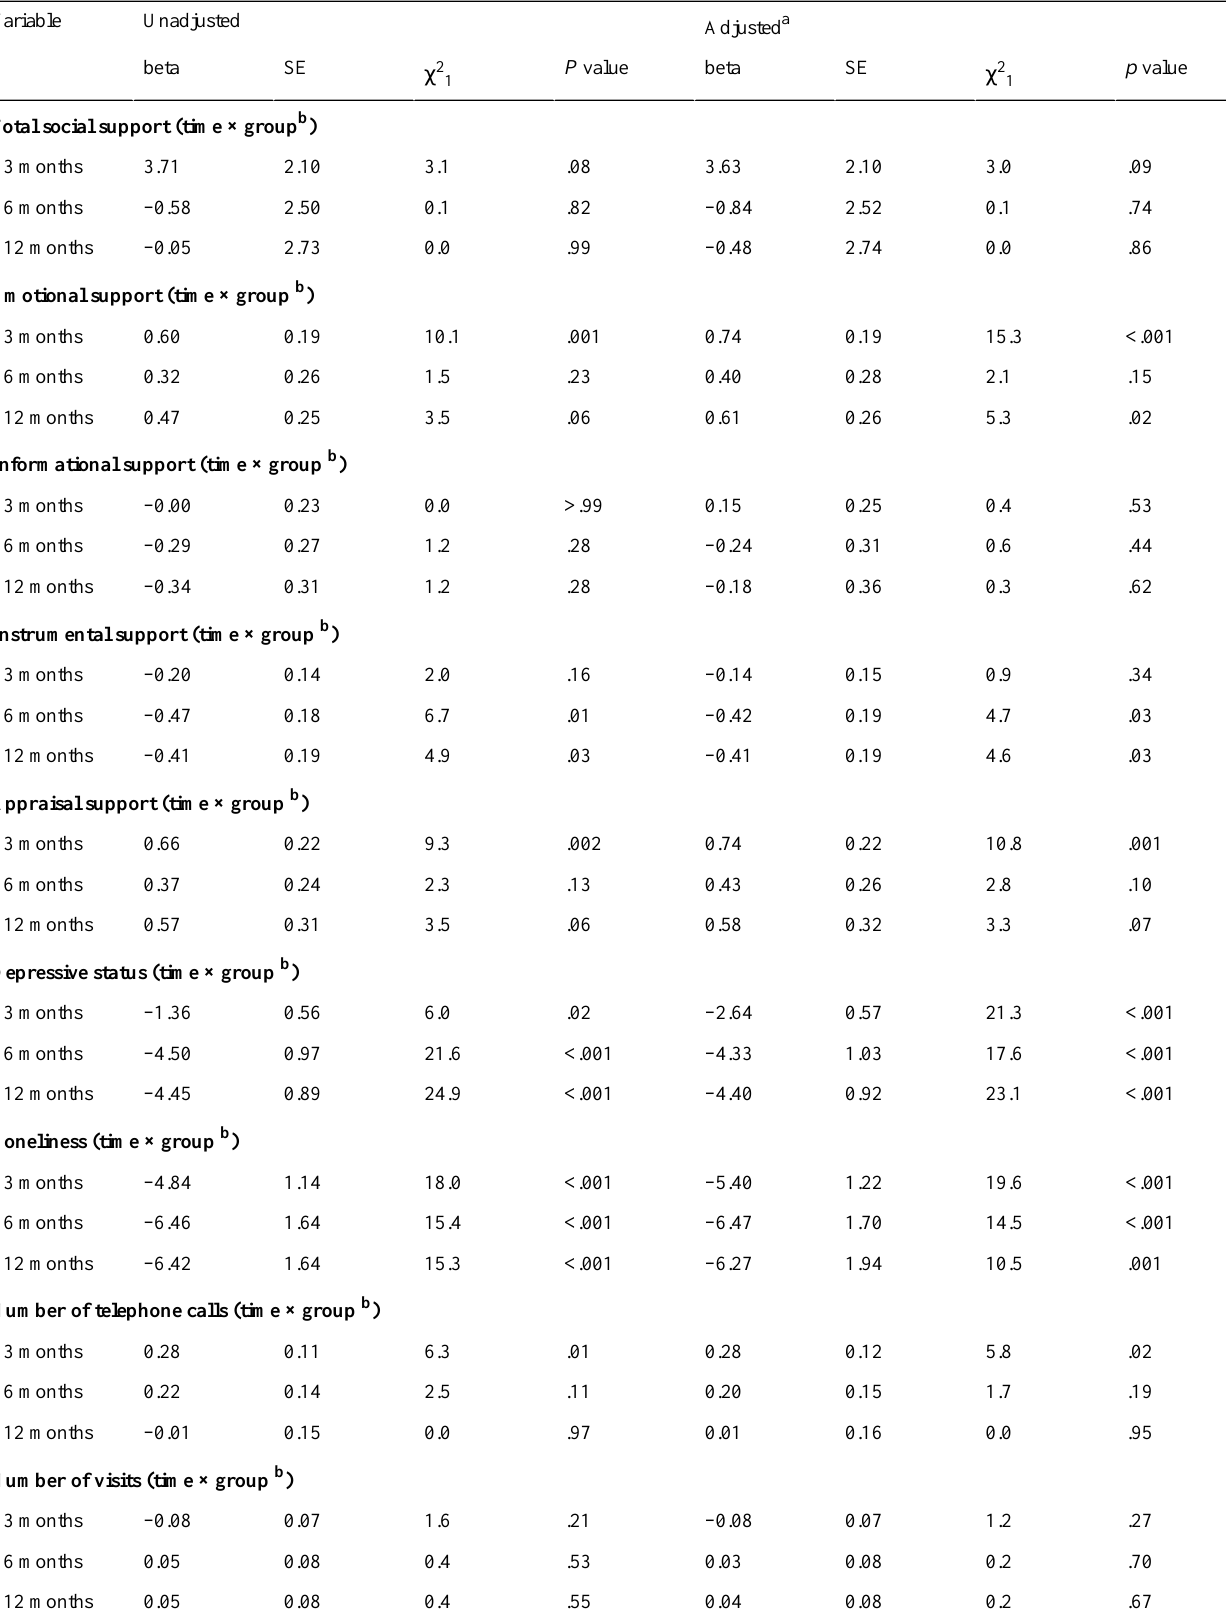
Table 4. Effects of videoconference intervention on participants’social support, depressive status, and loneliness at 3, 6, and 12 months in consideration of time × group